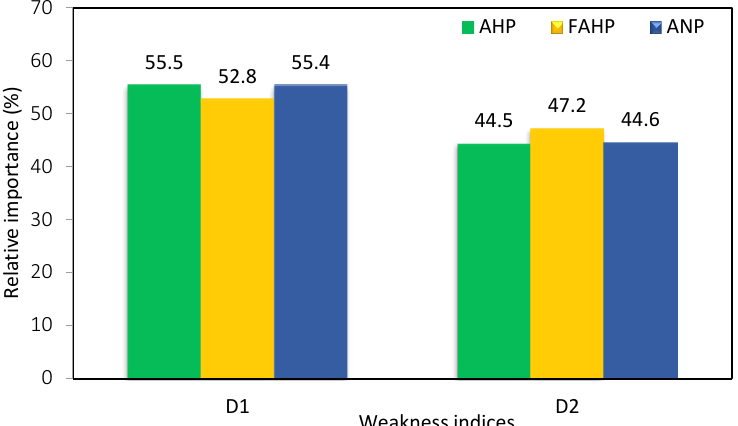
Fig. 5: Comparison of relative importance (weights) of second-level weakness indices of D using AHP, FAHP, and ANP